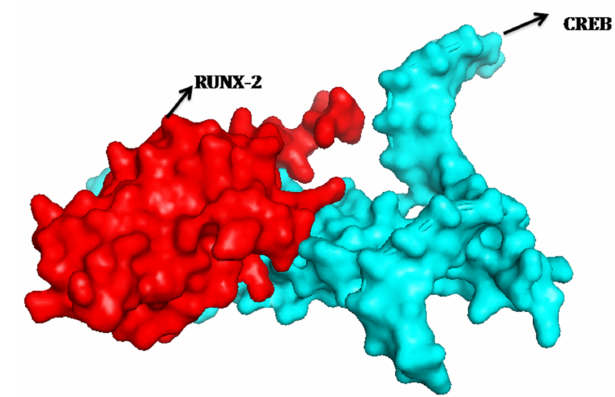
Figure 7. Protein–protein interaction of Runx2 with